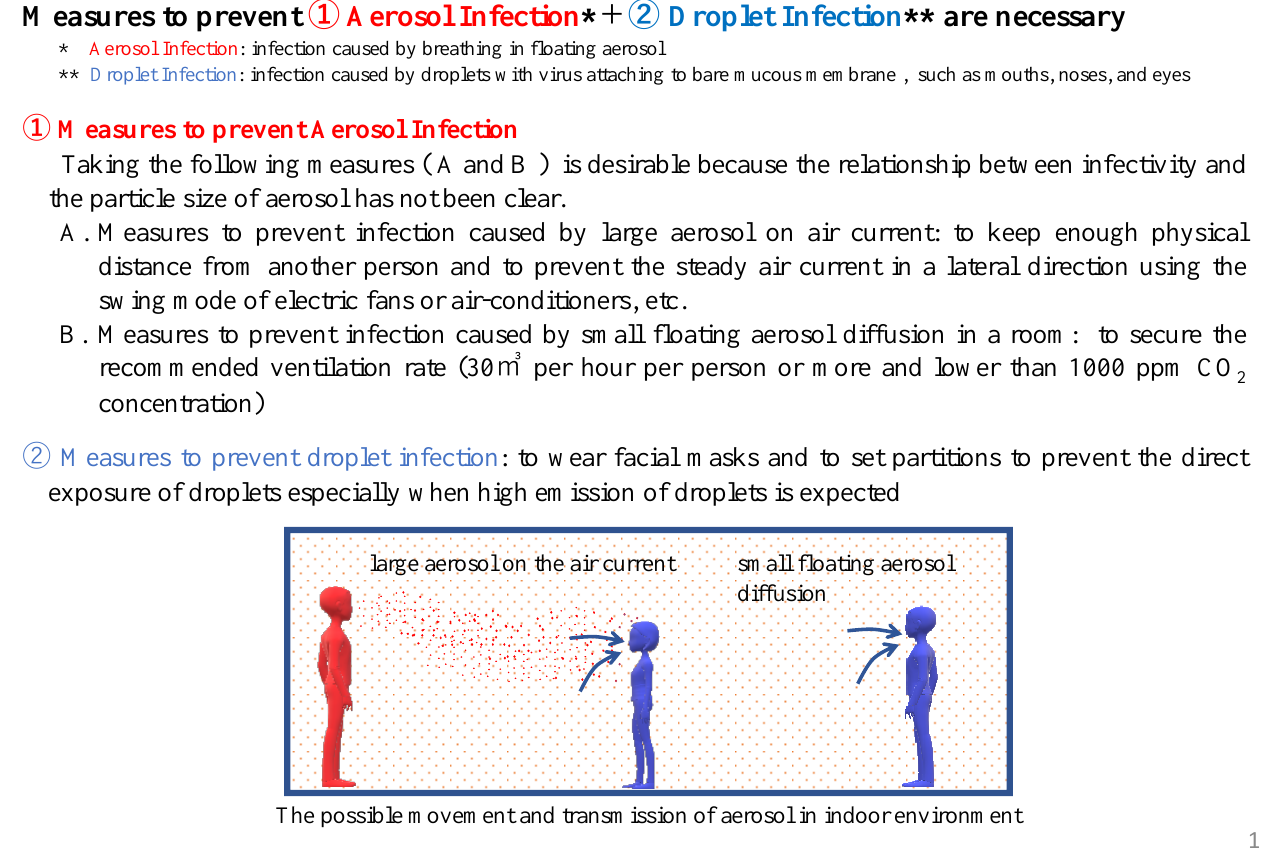
Figure 8. Measures to prevent two types of aerosol movement.